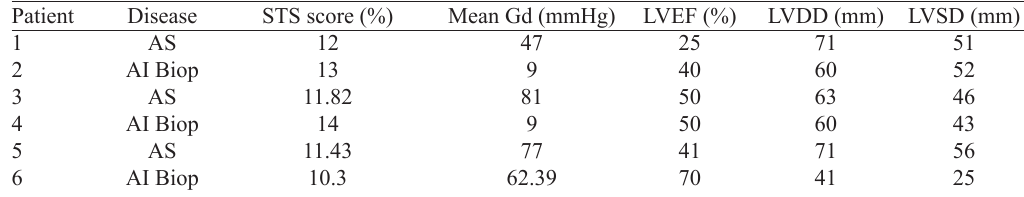
Table 4. Aortic valvular disease, STS scores and preoperative echocardiographic parameters.